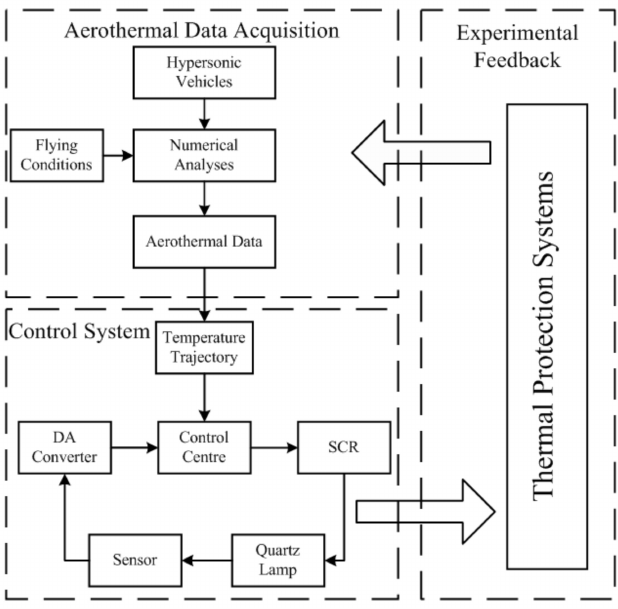
Figure 2. The flow chart of the AHGSHV